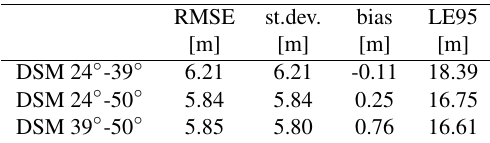
Table 3: DSMs assessment for TerraSAR-X descending dataset